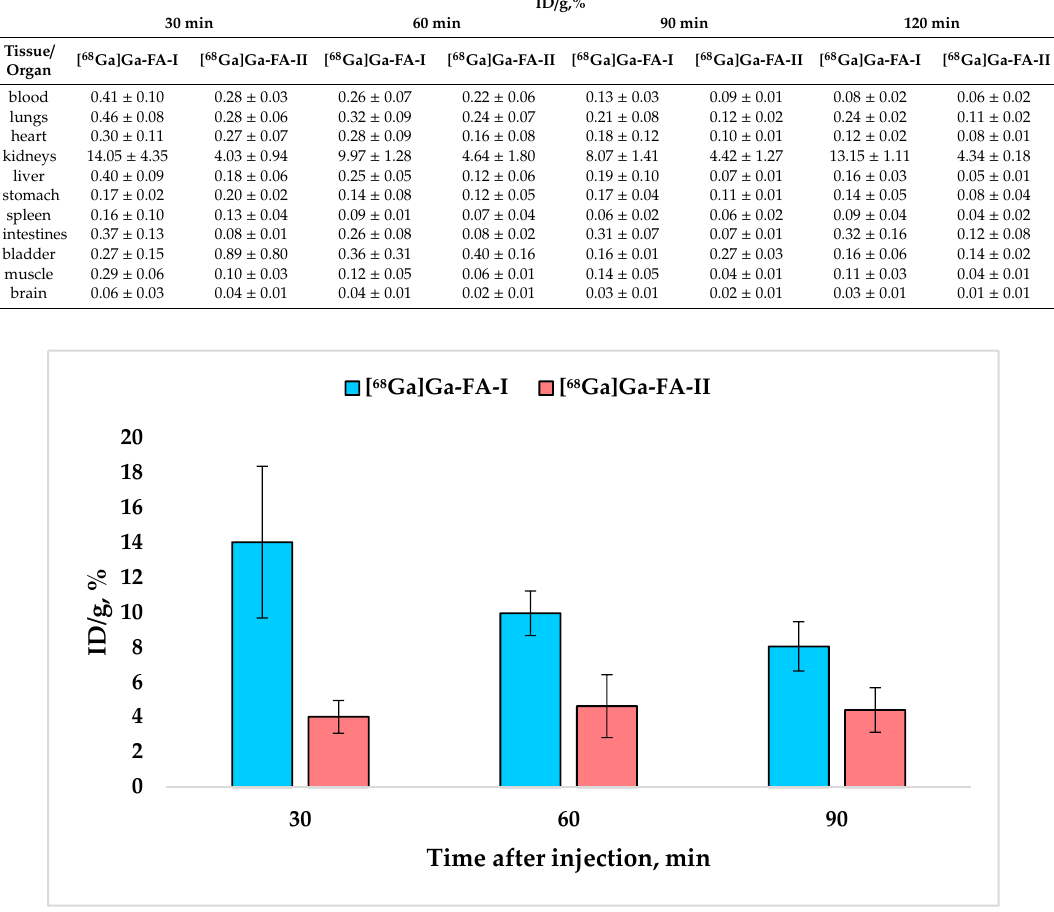
Figure 4. Accumulation of [ 68 Ga] Ga-FA-I and [ 68 Ga] Ga-FA-II in kidneys ( mean ± SD, n = 5 ).